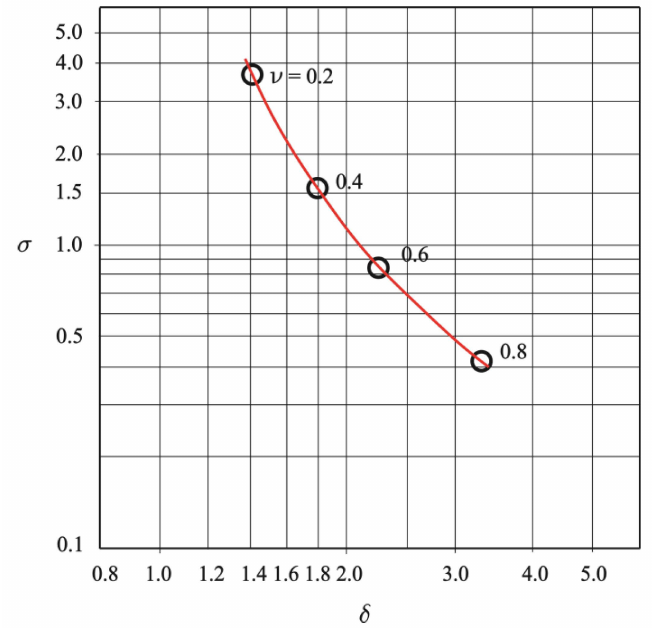
Figure 2. Axial fans and minimum hub-to-tip ratios ν for free-exhausting impeller-only fans, after ECK [1], 1972 (p.